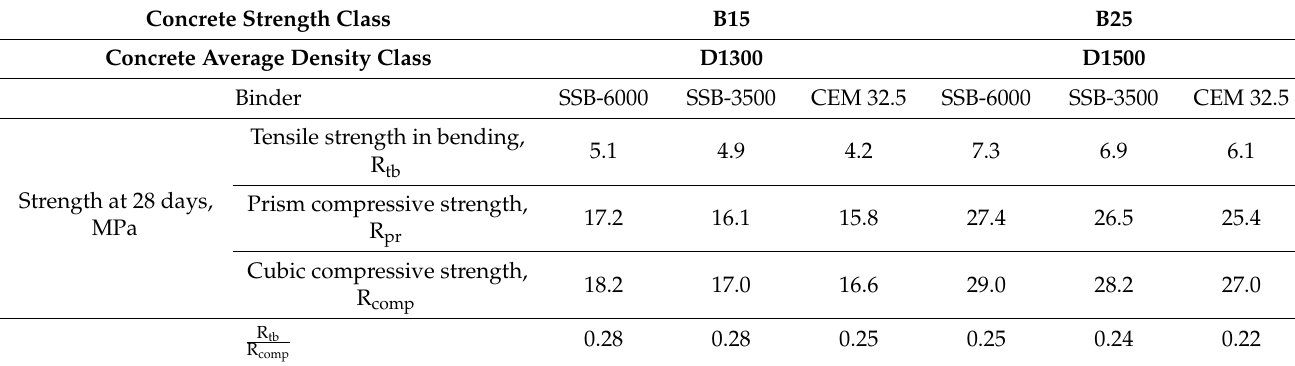
Table 7. Mechanical properties of lightweight